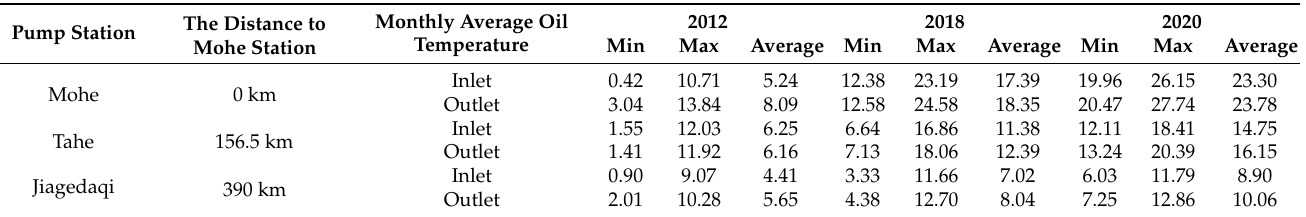
Figure 8. Monthly average inlet and outlet oil temperatures of the Mohe, Tahe, and Jiagedaqi pumping stations (2011–2020) of the CRCOP’s first line. Table 3. Characteristic values of the Mohe, Tahe, and Jiagedaqi pumping stations’ monthly average inlet and outlet oil temperatures, 2012, 2018, and